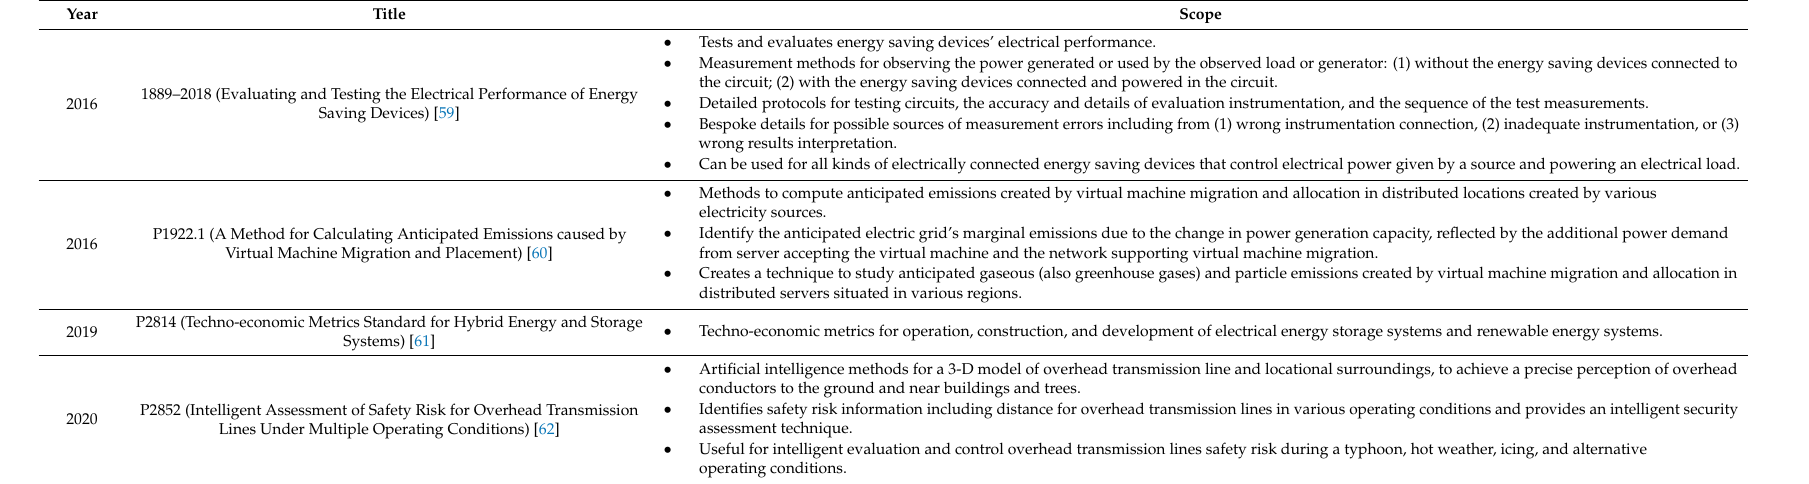
Table 1. Recent Institute of Electrical and Electronics Engineers (IEEE) Standards in development for a smart grid and smart